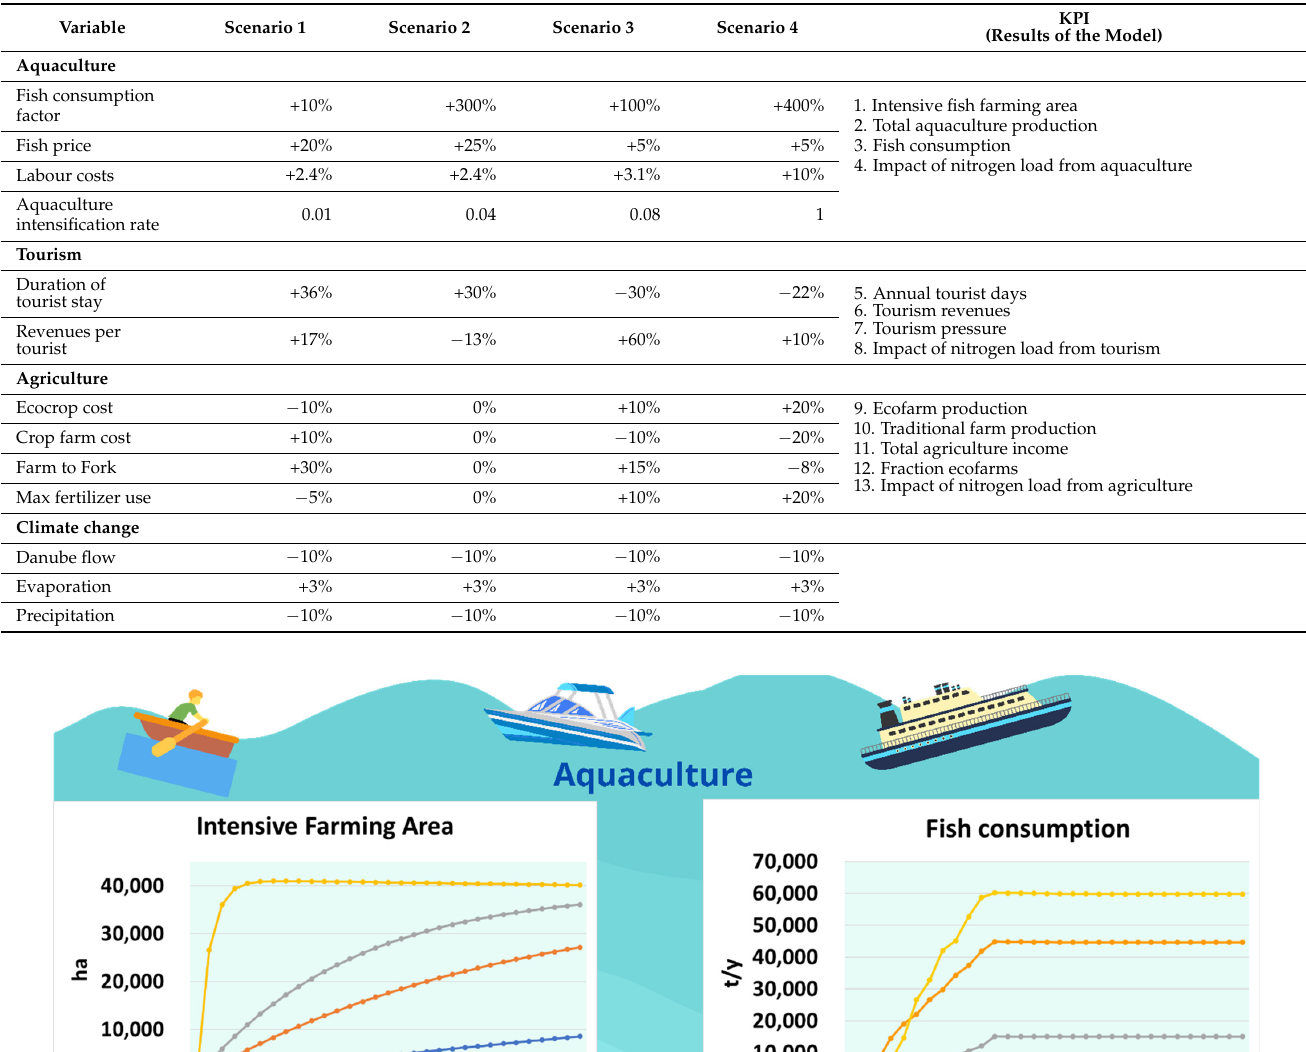
Table 2. Variable changes according to defined scenarios and the model’s KPIs.